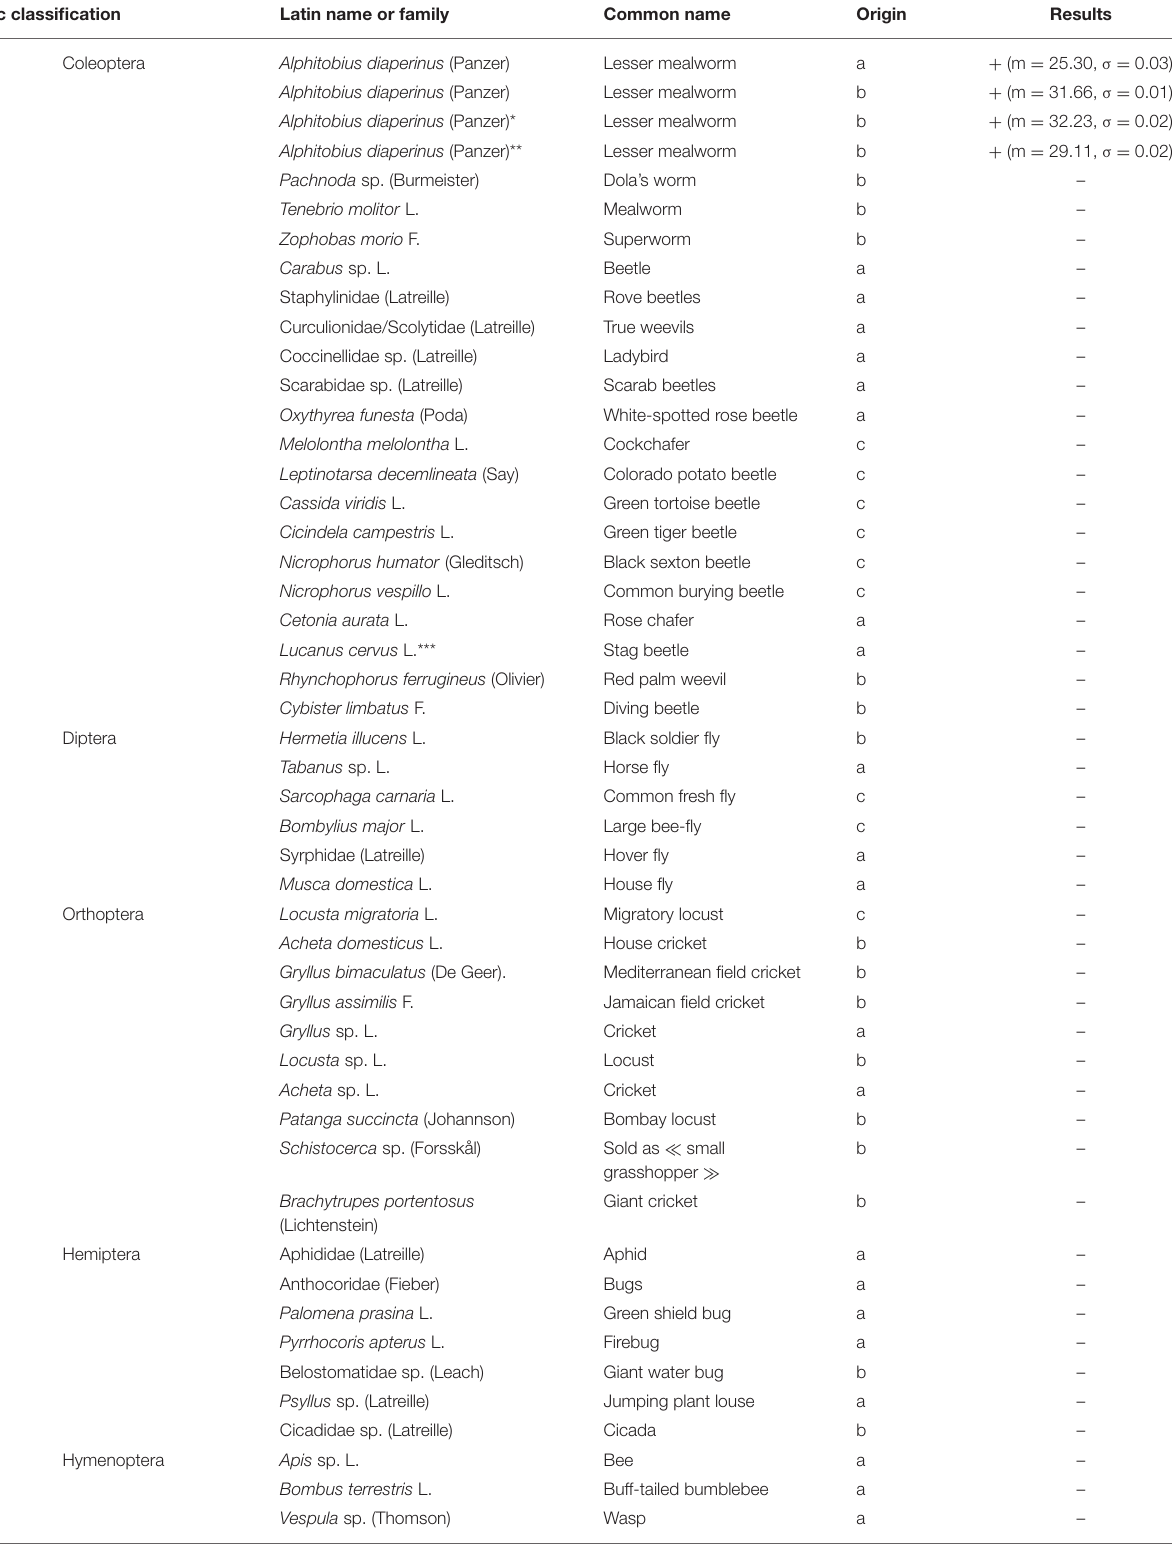
TABLE 2 | Specificity of Alphitobius diaperinus PCR test on animal and plant species ( n =